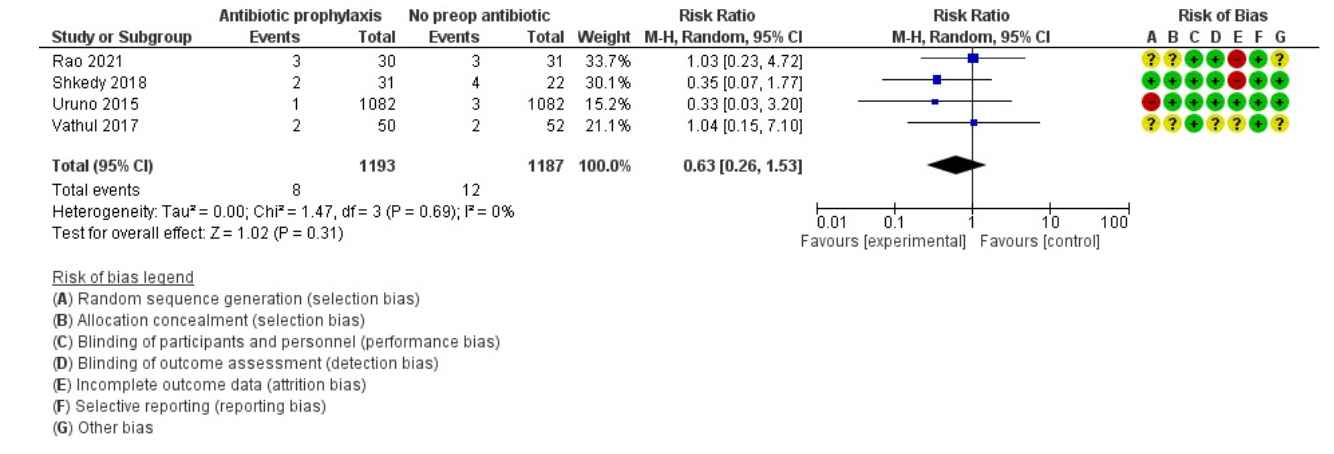
Figure 4. Forest plot for SSI rate in AP group vs. control group (no AP)—RCTs only.